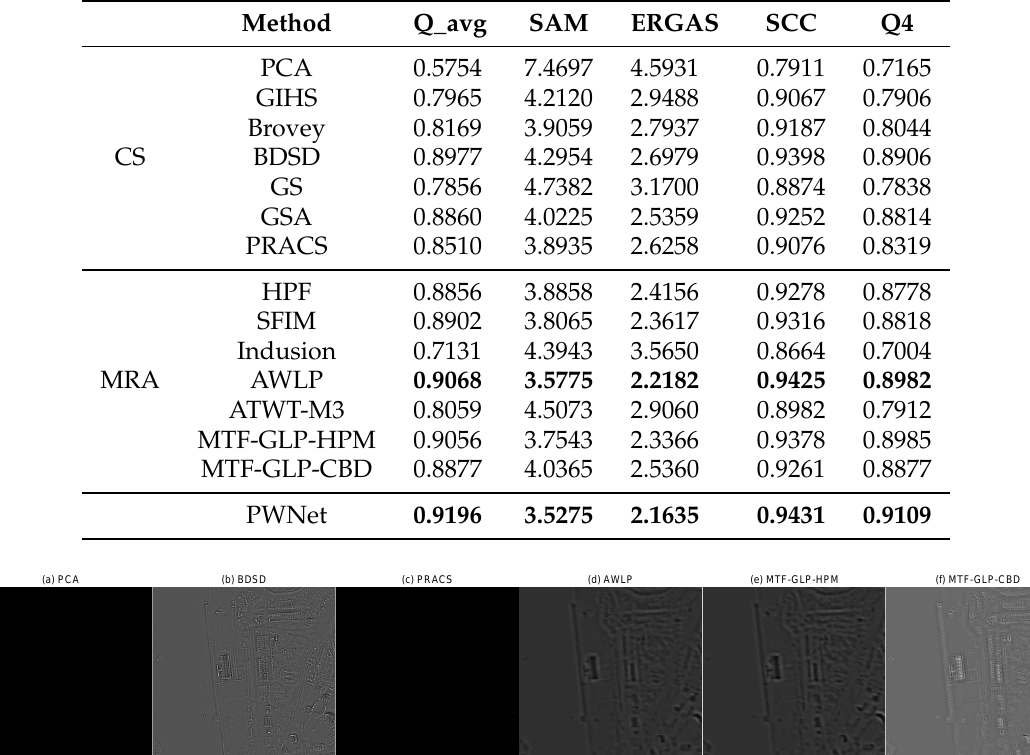
Table 7. Quantitative comparison of the the CS-based and MRA-based methods and the proposed PWNet method on the QuickBird images. The best and second best results are highlighted in bold.